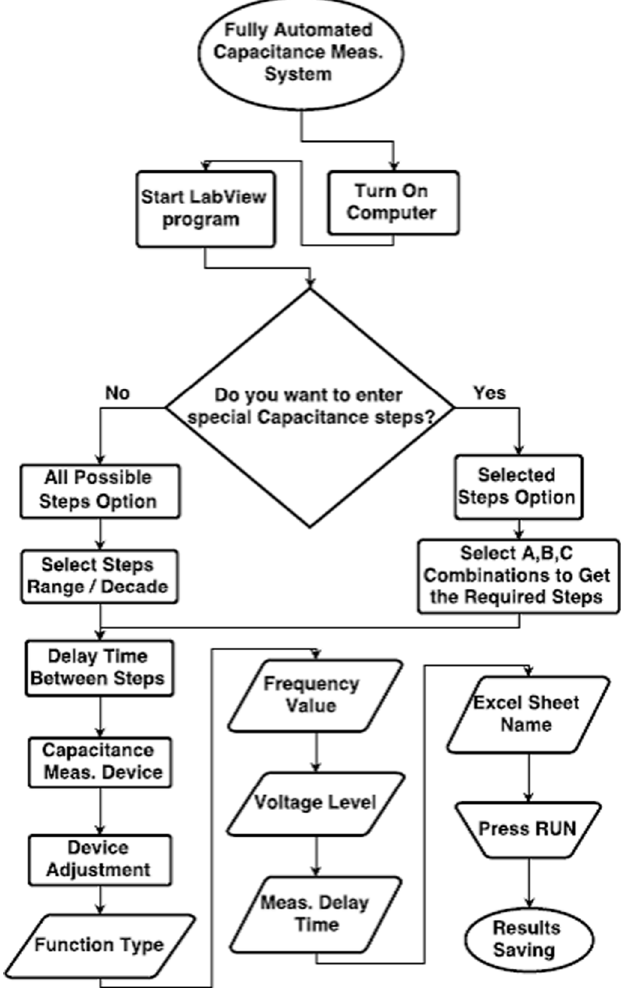
Fig. 4. Flow chart of the completely automated system for capacitance